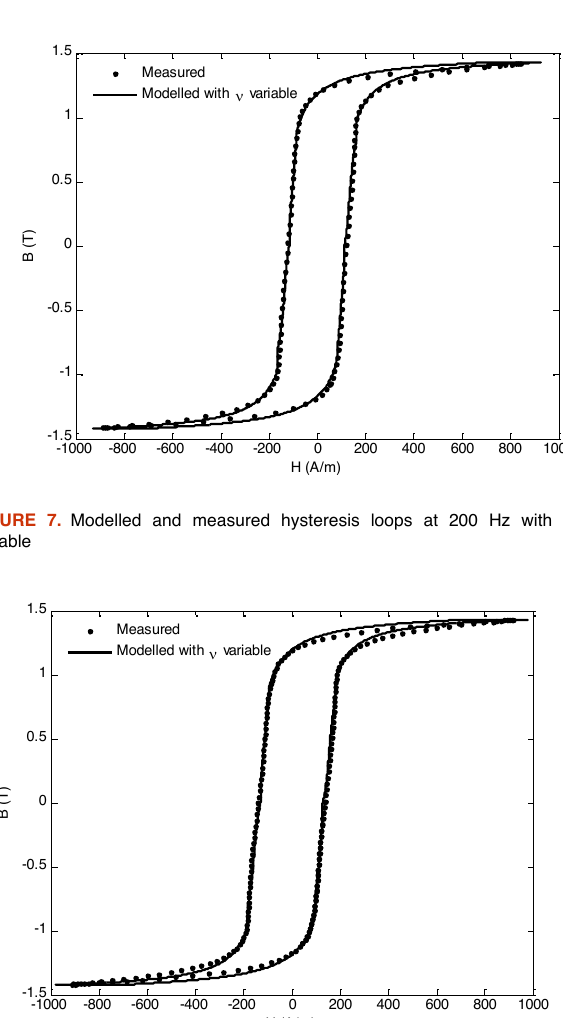
FIGURE 6. Modelled and measured hysteresis loops at 300 Hz